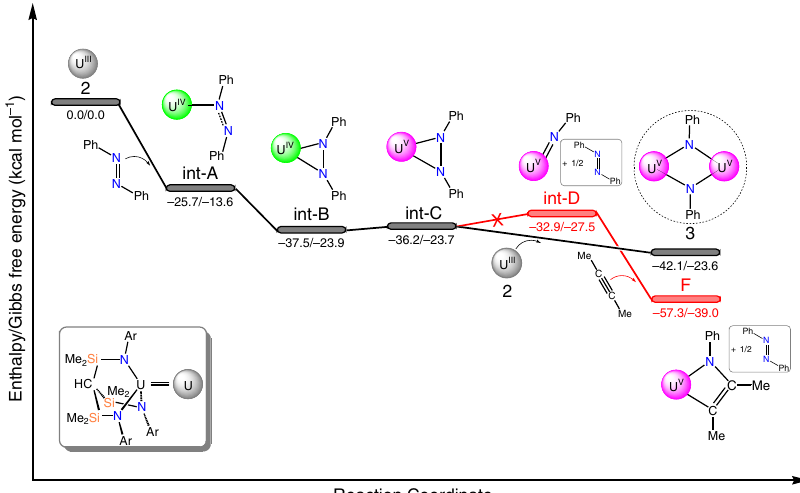
Fig. 8 Computed reaction pro fi le of the reaction of 2 with PhNNPh to give 3 via an overall oxidative addition reaction. Values given are quoted as computed enthalpy/Gibbs free energies